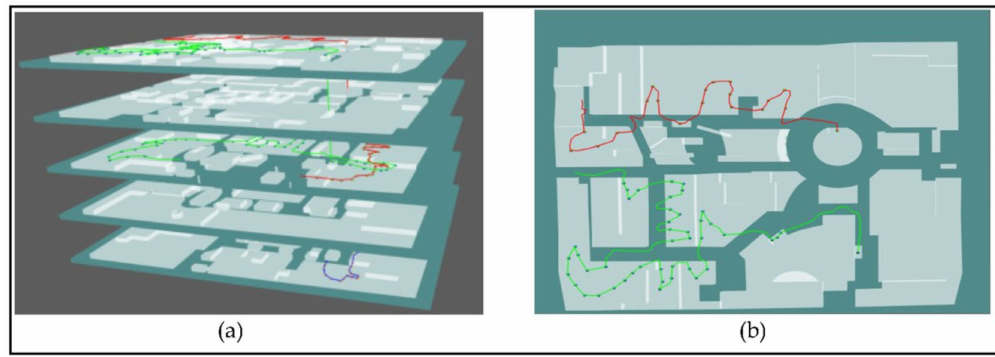
Figure 5. Trajectories diagrams. ( a ) Three-dimensional schematic; ( b ) trajectory plane schematic.